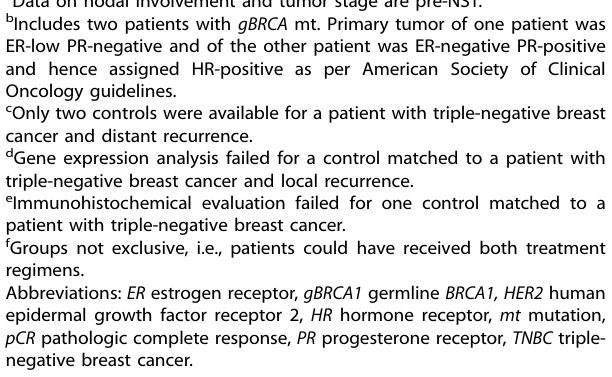
Patients with relapse